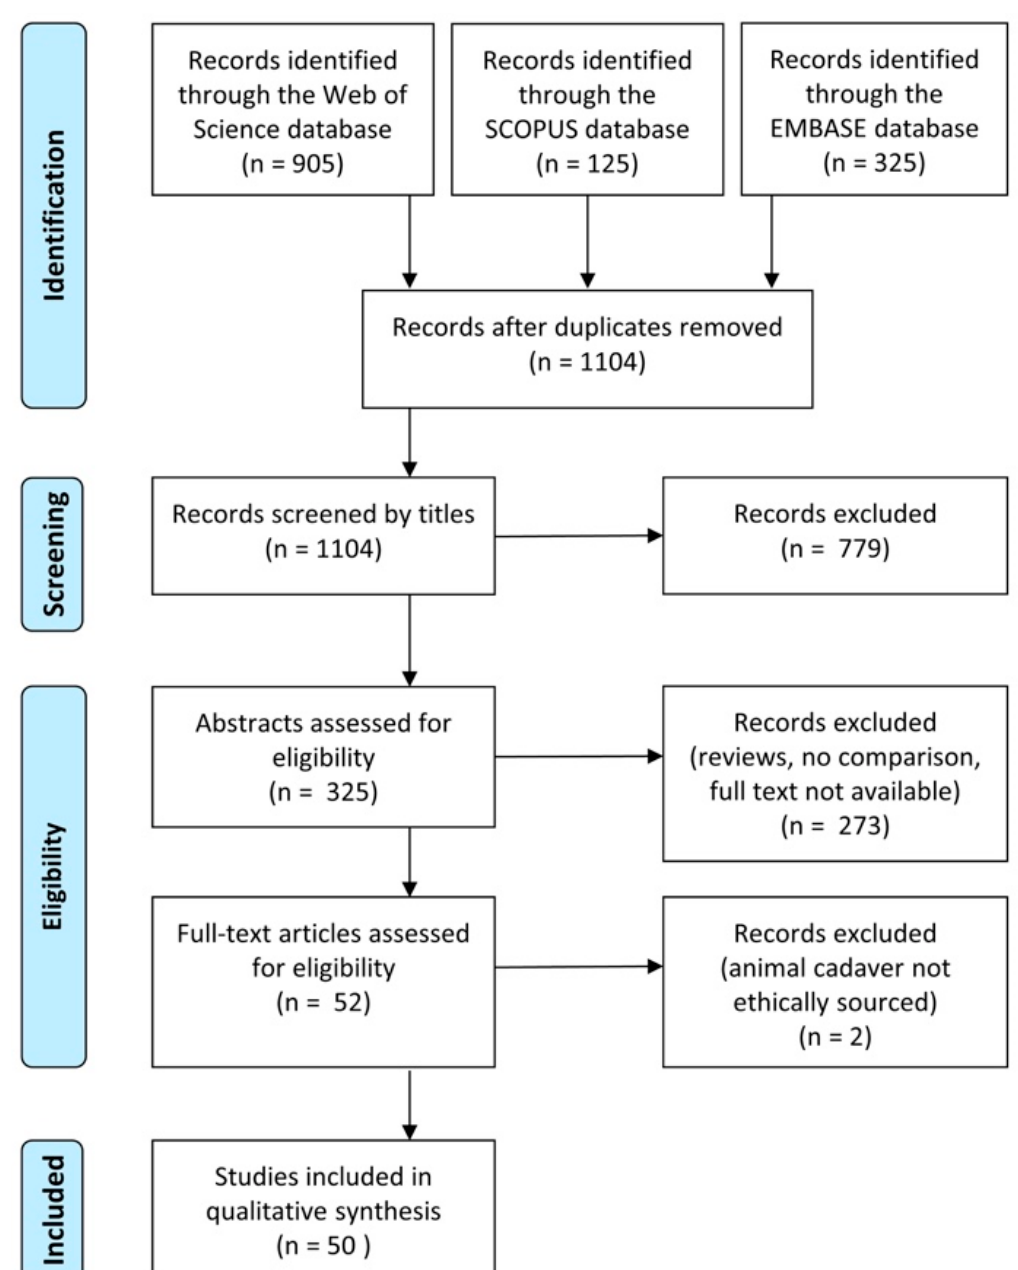
Figure 1. PRISMA literature search flow diagram. The number of studies (n) that were identified, screened, retained, or discarded are shown at each stage of the systematic review process.